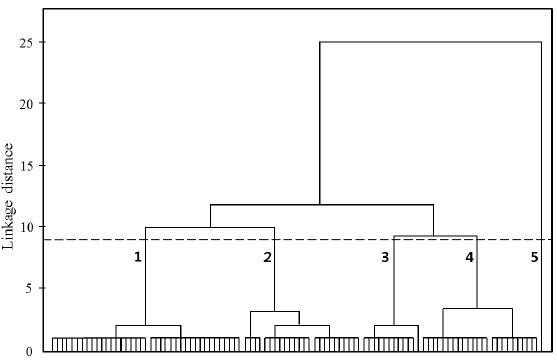
Figure 4. Dendrogram from hierarchical cluster analysis .